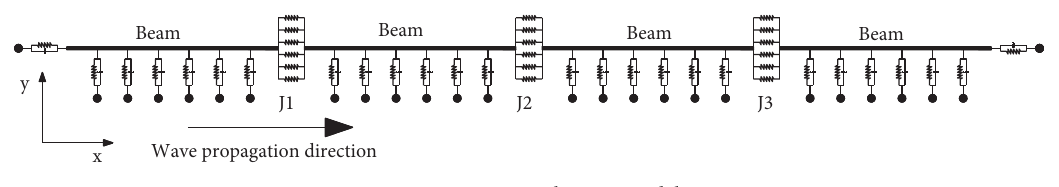
Figure 17: Finite Element